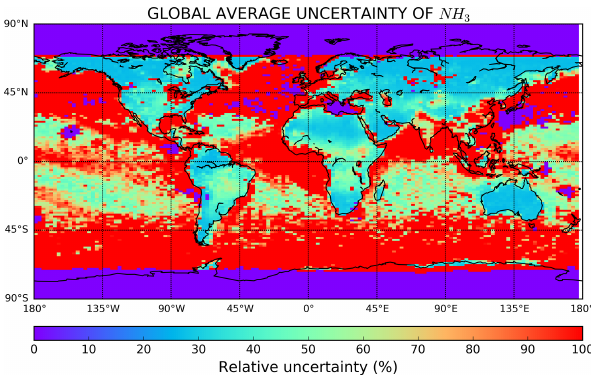
Figure 10. The 10-year average relative uncertainty of modelled surface concentrations expressed as the standard deviation of sur- face concentrations from a model ensemble (Table 1) divided by the average.